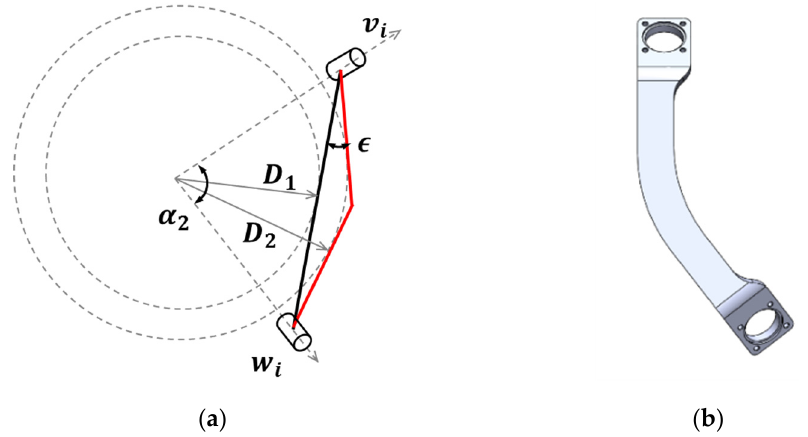
Figure 5. Description of the curved link: ( a ) the curved link (red) offers an increased ISM compared to the straight one (black) ( D 2 > D 1 ), ( b ) the design of the curved link.